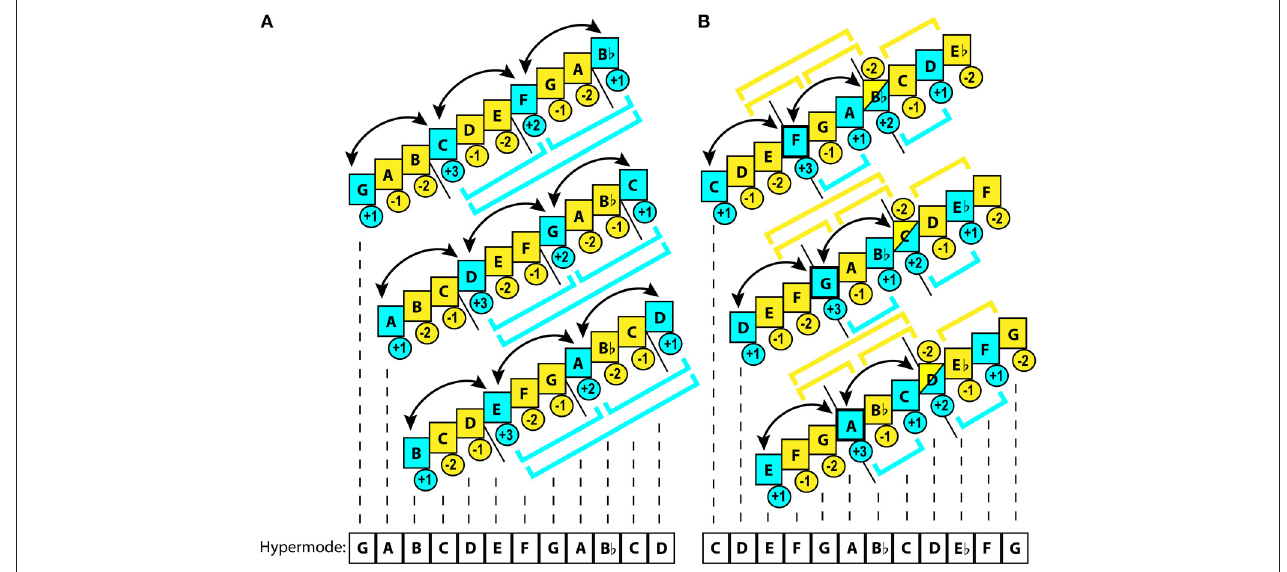
Figure 3 | Different types of non-octave hypermode. 27 Yellow color represents unstable, while blue—stable degrees. Brackets illustrate hierarchic grouping of the degrees. Arrows mark the tendency of the tones to alternate as gravitational centers. Figures in circles rate relative gravitational values within the subset. Short black straight lines mark the modal subsets within a hypermode: when a line is placed under the middle of a tone, this tone serves as an anchor for two subsets, generating the conjunct connection between them. (A) Three obykhodnyi hypermodes of the hexáechos system: major (G), minor (A), and diminished (B). This hypermode features nearly perfect subset equivalence . Hierarchical organization is present only for stable degrees, where the lowest pair (G-C) often generates a plagal inclination. The highest stable degree (Bb) is hardly ever used as finalis, which usually falls on the central anchors (C or F). Unstable degrees do not form any groups, as in pentatony. However, tension here is weaker than in pentatony because of deeper 3-level hierarchy of stable degrees. Position of a semitone marks the “leading tone.” Anchor points relate to each other by 4th, readily forming the 4th–chord “triads” that are treated like consonance. (B) Three Georgian tetrachordal hypermodes: major (C), minor (D), and diminished (E). Unstable tones in the center of the hypermode provide modal integrity by forming unstable dyads (E-G, G-Bb), entrapping the central tonic dyad (F-A). Sometimes this tonic dyad alternates in gravity with the upper tetrachord’s anchors (Bb-D). Whenever this happens, Bb shifts from unstable to stable function. However, the hypermode remains centripetal due to the harmonic dissonance of the diminished octave E/Eb, which generates a melodic inertia toward the inward resolution. The lowest tetrachord executes a complimentary plagal function. The utmost upper tetrachord usually keeps its highest tone unstable, leaning on its lowest tone. Altogether, the tetrachords feature subset inequivalence : gravitational contrast between each other (unlike the trichord hypermode). Tonal mapping of the major hypermode (centripetal F) serves as a prototype for the minor (G) and diminished (A)